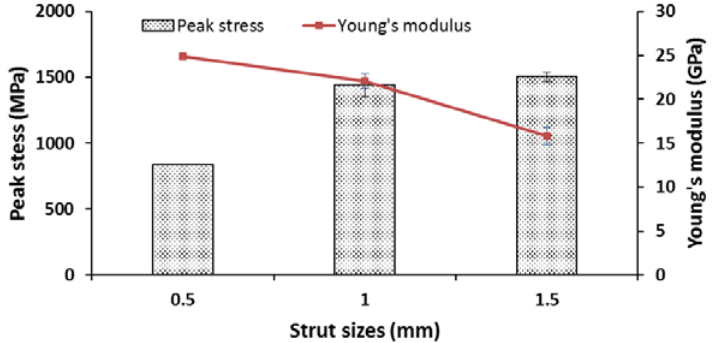
Figure 21. Compressive properties after correcting for the designed cross-sectional area of the struts (modified scan strategy).